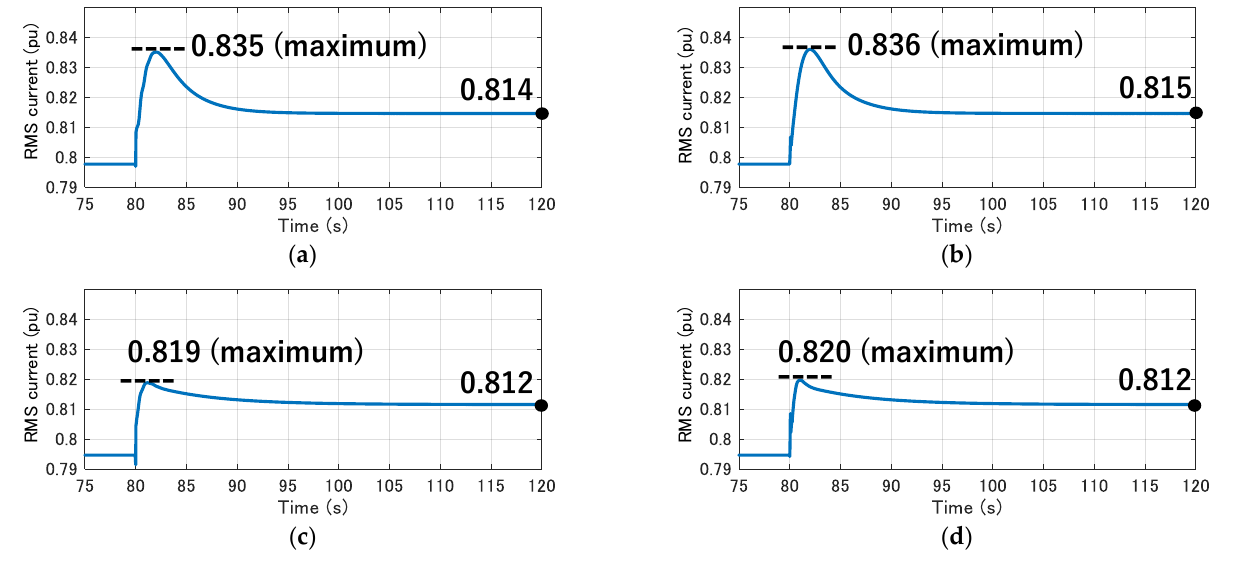
Figure 9. IBR output current. ( a ) 20% IBR penetration, VI-GFM, ( b ) 20% IBR penetration, VI-GFL, ( c ) 60% IBR penetration, VI-GFM, ( d ) 60% IBR penetration, VI-GFL. Table 4. Current limitation settings